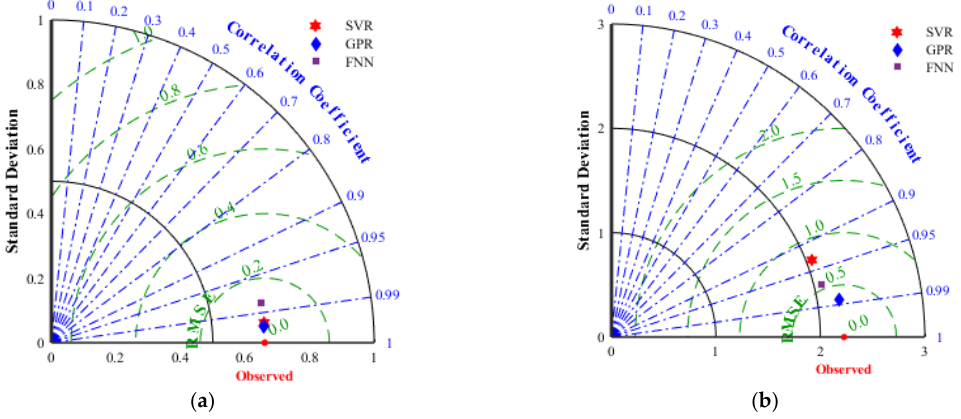
Figure 9. The Taylor diagram of predicted and observed values: ( a ) H ip 2 and ( b ) η d . Figure 10 shows the relative deviation (RD) of all models on the training and test data. The smaller the RD range of the model is, the more efficient the model results are. For the prediction results of H ip 2 , the RD of the GPR model is in the range of [ − 4, 4] and [ − 2, 2] in the training and testing sets. Compared to the SVR model (training set [ − 4, 6] and testing set [ − 4, 4]) and the FNN model (training set [ − 15, 15] and testing set [ − 7, 10]), the margin of error is smaller. For the prediction results of η d , the RD of the GPR model is mainly distributed in the range of [ − 1,1] on the training and testing sets. The range is smaller compared to the SVR ([ − 2, 2]) and FNN ([ − 1.5, 1]) models. When combining the cumulative frequency and the absolute relative deviation (ARD) percentages (see Figure 11), for the prediction results of H ip 2 , the cumulative frequency of the GPR model is within 3% and the ARD is 98.64%, which is significantly higher than that of the SVR (96.71%) and FNN (78.87%) models. For the prediction of η d , the cumulative frequency of the GPR model is within 1% and the ARD is 99.41%, which is also higher than that of the SVR (92.64%) and FNN (97.09%) models. Based on the above analyses, it can be seen that the GPR model has a higher prediction accuracy for the weighted efficiency and the impeller head, and the GPR model is finally determined as the proxy model for impeller optimiza- tion.